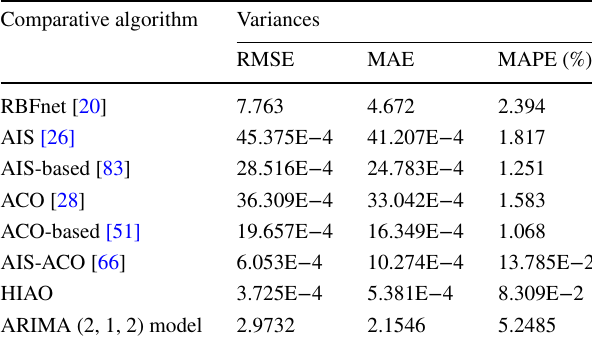
Table 7 The statistical result for T-test among all relevant